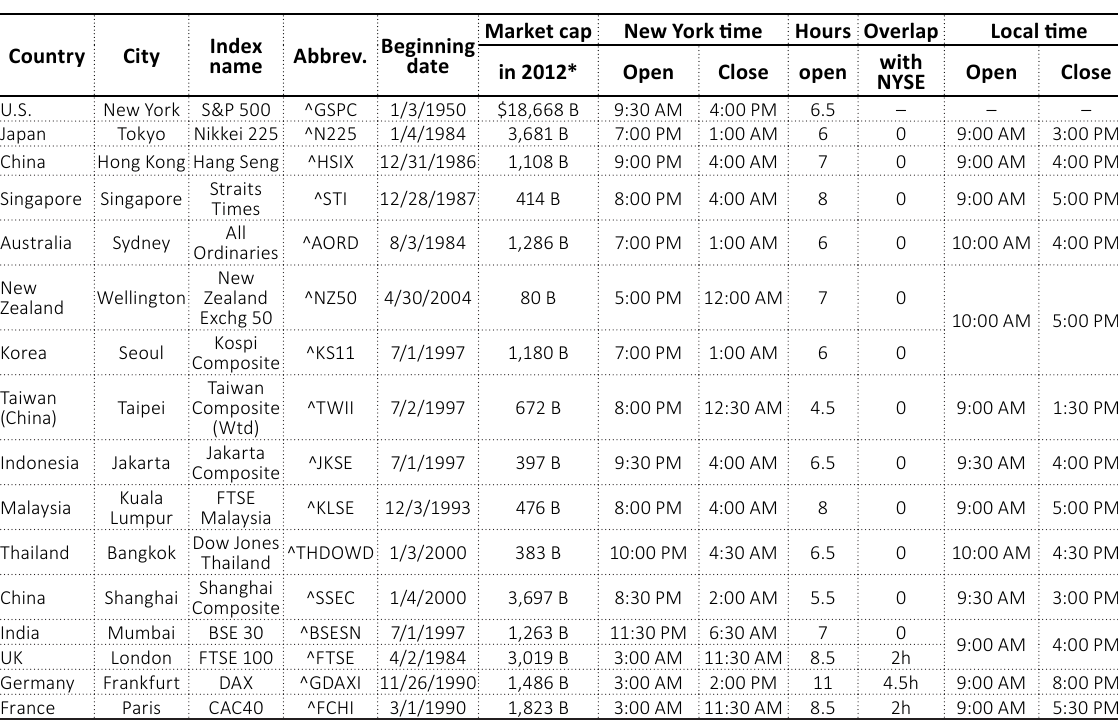
Table 1. Characteristics of markets and market